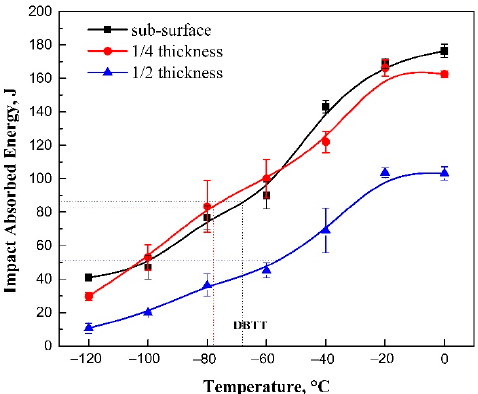
Figure 7. Absorbed energies of the experimental steel as a function of temperatures at the different thickness.